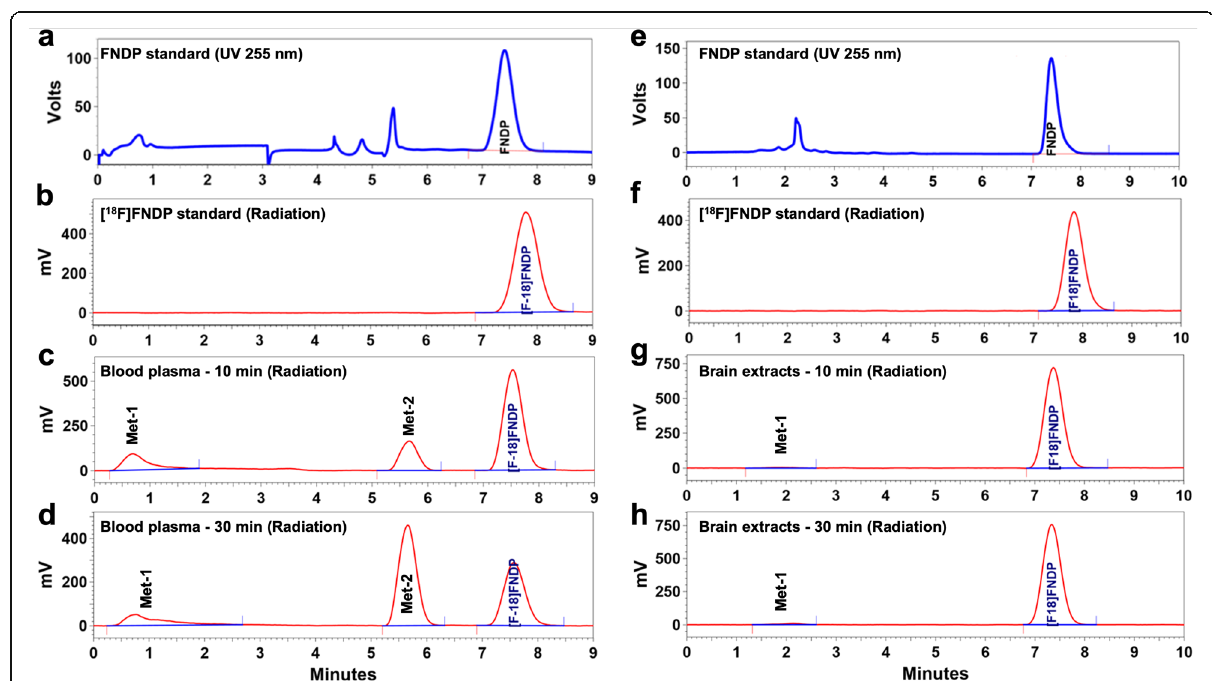
Fig. 8 Metabolism of [ 18 F]FNDP in mouse blood and brain. Representative HPLC chromatograms recorded for non-radioactive FNDP standard (blue), [ 18 F]FNDP standard (red) and blood plasma and brain extract samples obtained from mice injected with 1 mCi of [ 18 F]FNDP and sacrificed at 10 and 30 min after radiotracer injection (red). The offset (~ 0.5 min) between UV and radiation peak retention times is because the UV and radiation detectors are connected in series. a , b , c , and d Plasma samples are analyzed with inclusion of a capture column. e , f , g and h Brain extracts are analyzed with no capture column. The study demonstrated presence of two major radiometabolites (Met-1 and Met-2) in the mouse plasma, but only a small amount of radiometabolite Met-1 entered the mouse brain